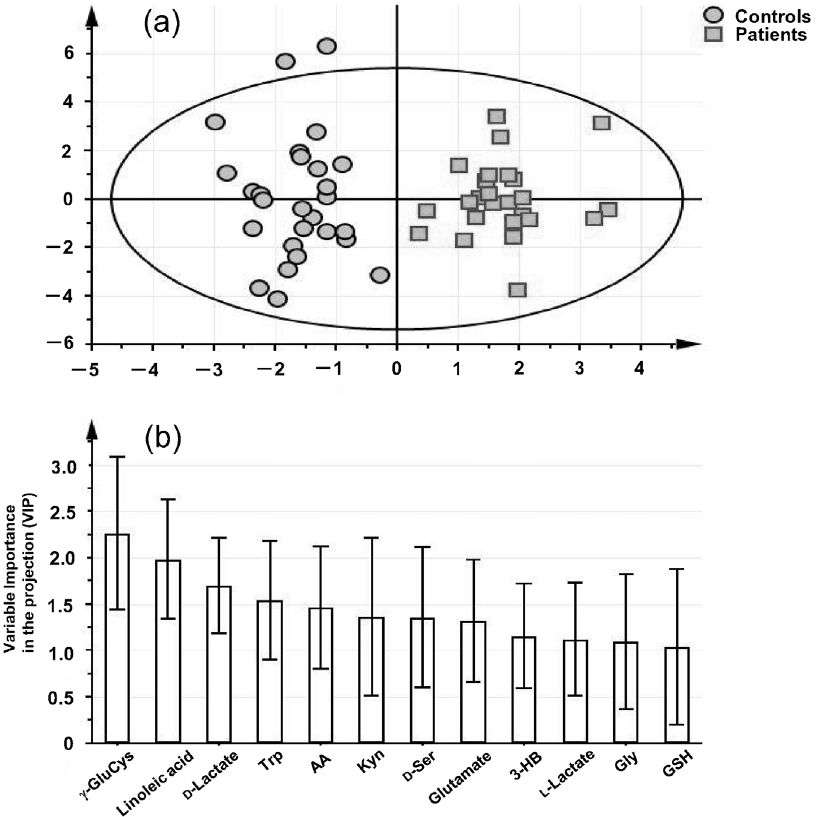
Figure 1. Score plot derived from orthogonal partial least square-discriminant analysis (OPLS-DA) based on the serum levels of 34 targeted metabolites in the subjects (a), and variable importance in the projection (VIP) data of the compounds with VIP values above 1.0 (b).